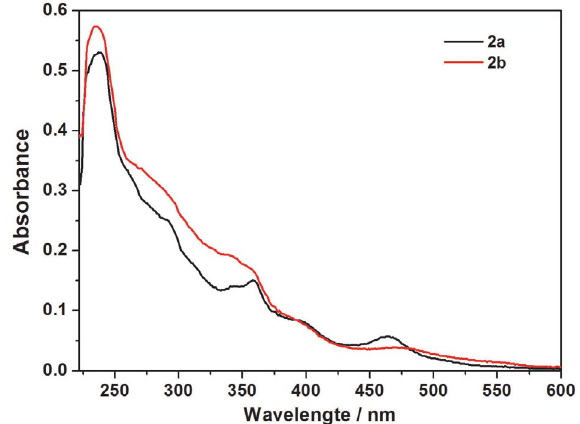
Fig. 2. Electronic absorption spectra of 2a–2b in CH 2 Cl 2 at room temperature.